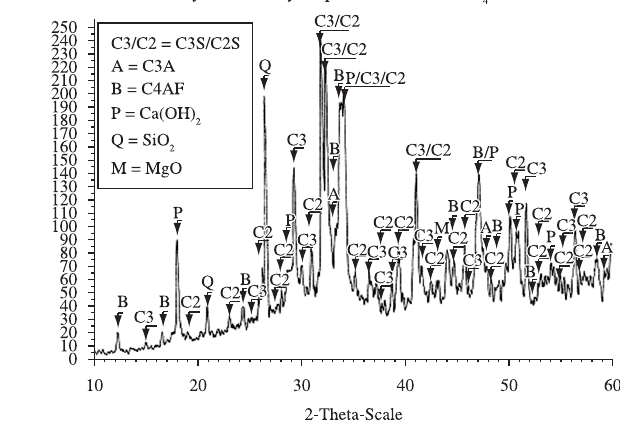
hydrated samples. This is indicated by the differences in the peak areas (DTA peaks). In all the cases there are three endothermic peaks below 300 °C. The peaks are due to removal of adsorbed water and decomposition of ettringite and C-S-H phase. The strong endothermic peak at about 450 °C is due to decomposition of calcium hydroxide formed during hydration. The peak area in the case of FAOPC hydrated for 28 days in the presence of 0.1 wt. (%) superplasticizer and 2.0 wt. (%) sodium sulphate is found to be minimum. This shows